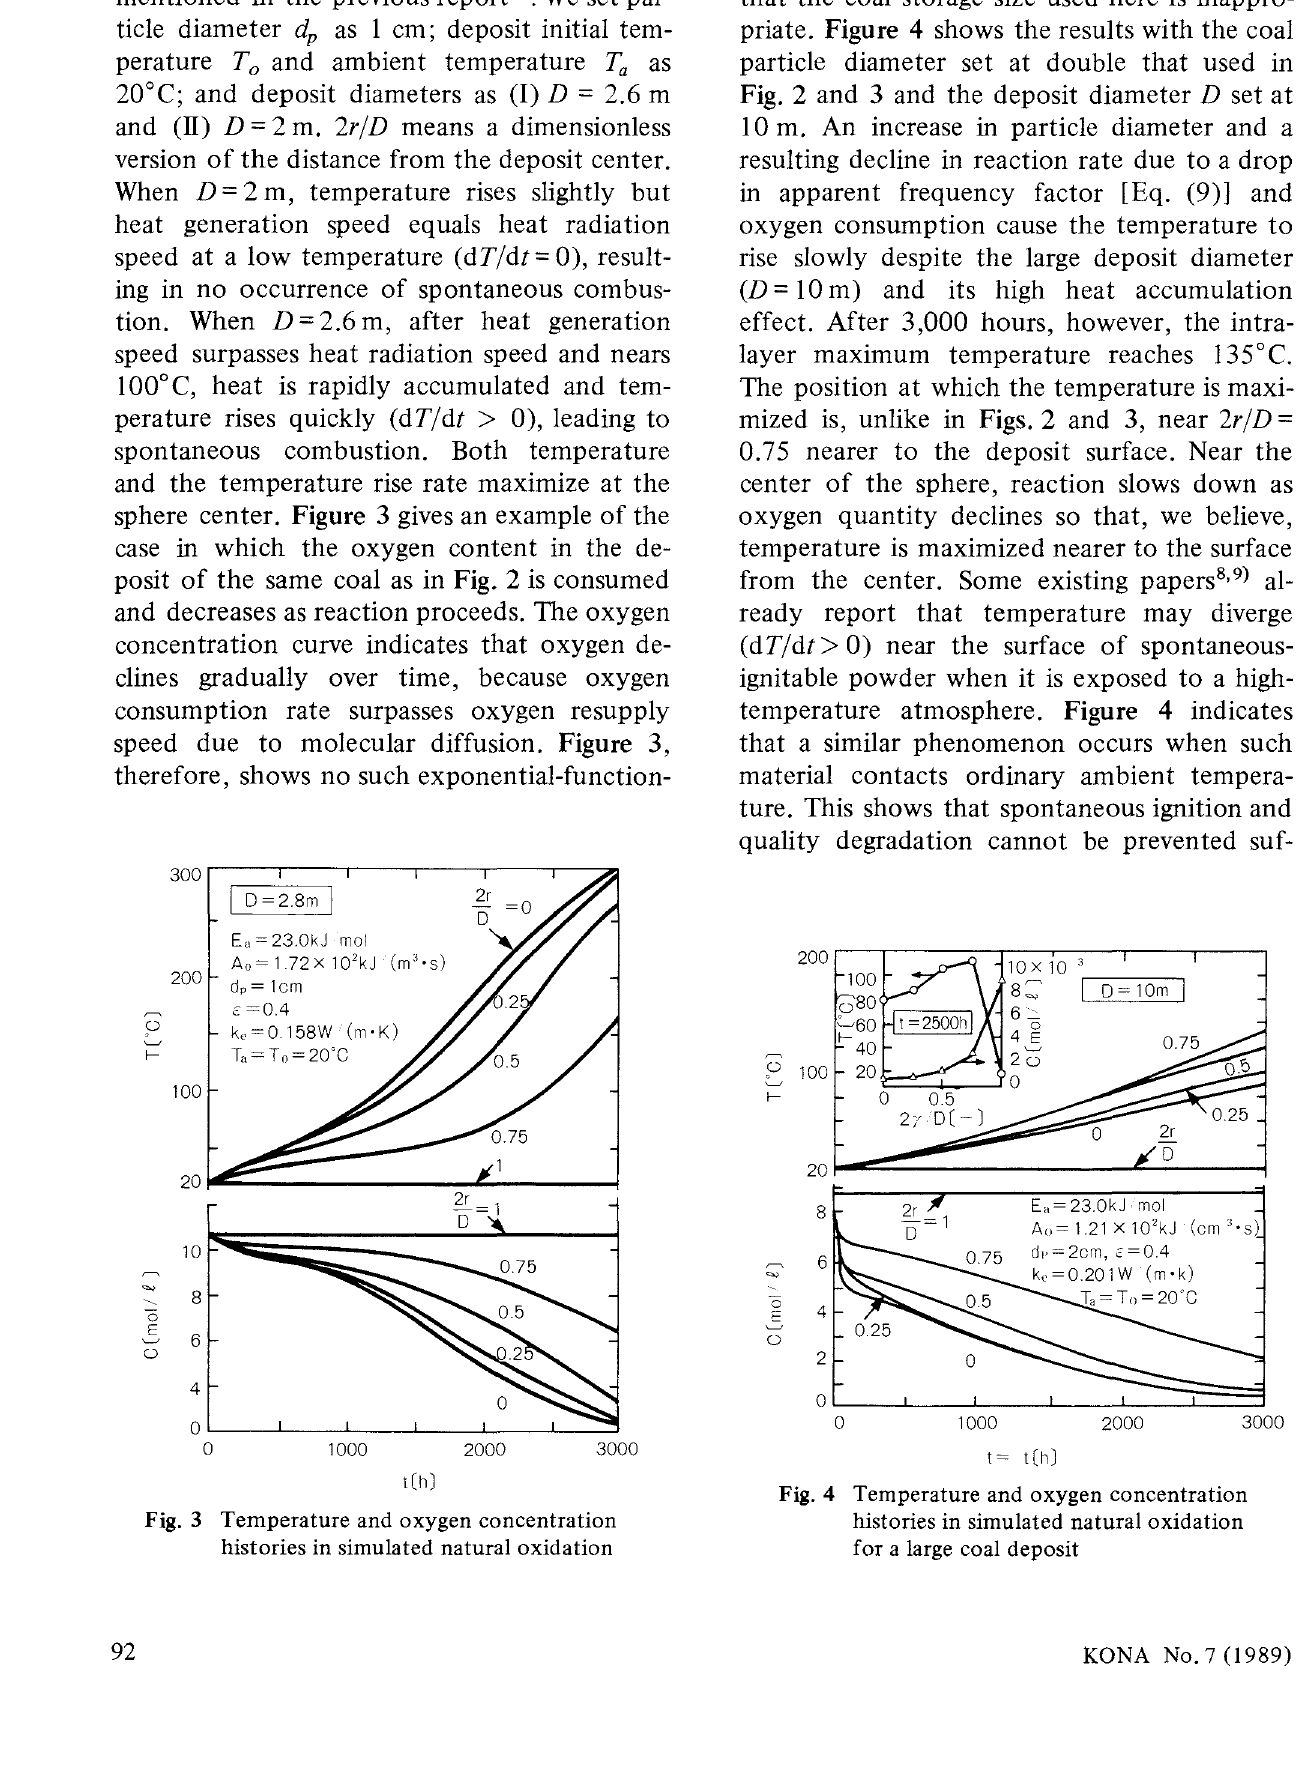
Fig. 4 Temperature and oxygen concentration histories in simulated natural oxidation for a large coal deposit